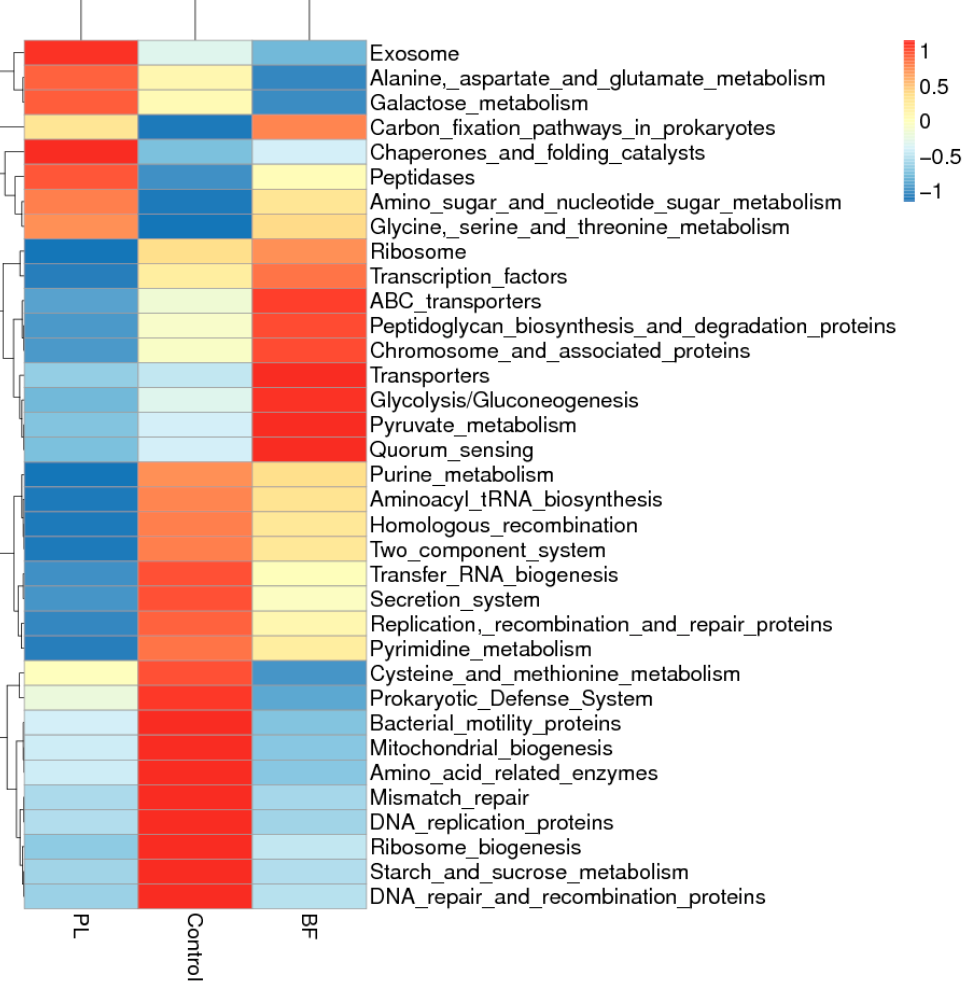
Figure 11. Heatmap of Tax4Fun functional prediction analysis for differential bacteria among the three groups. Note: PL means planktonic group; BF means biofilm group.